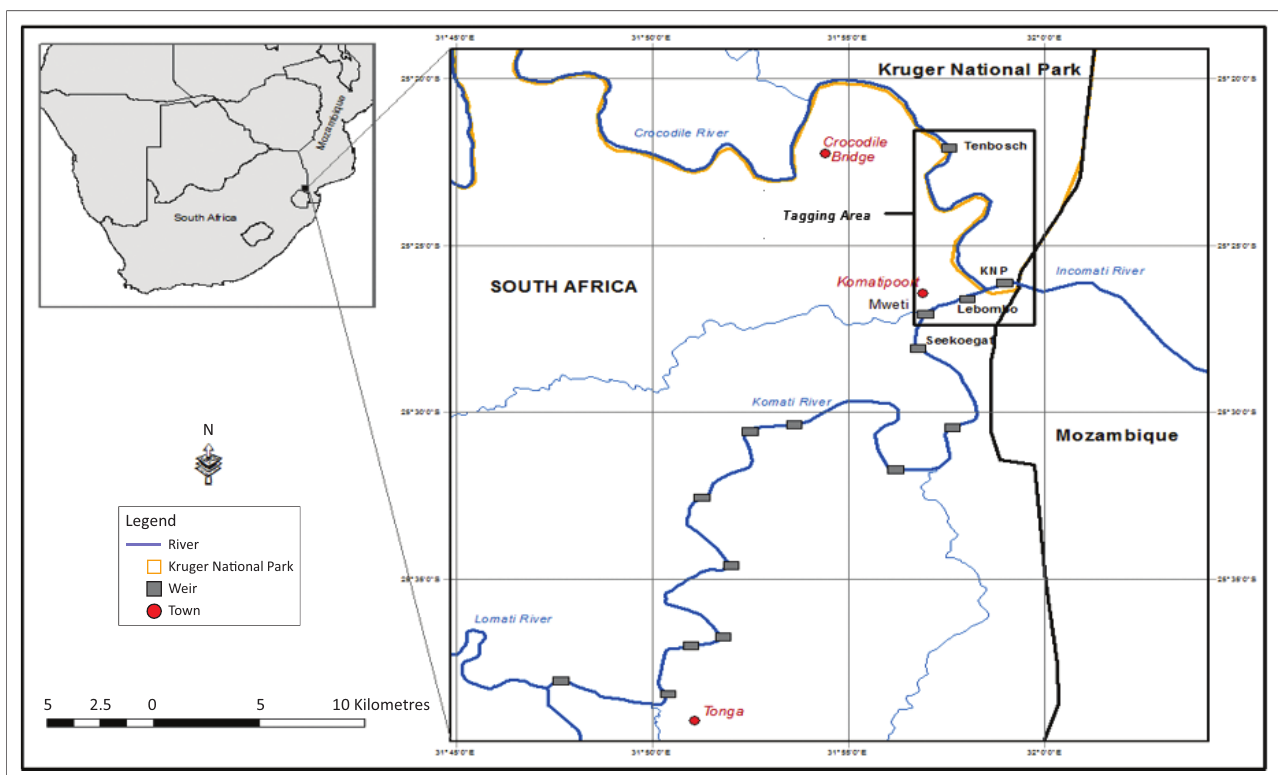
FIGURE 1: Map indicating the location of the study area in the Mpumalanga Province of South Africa, in close proximity to Mozambique. The applicable rivers are illustrated and marked with the numerous